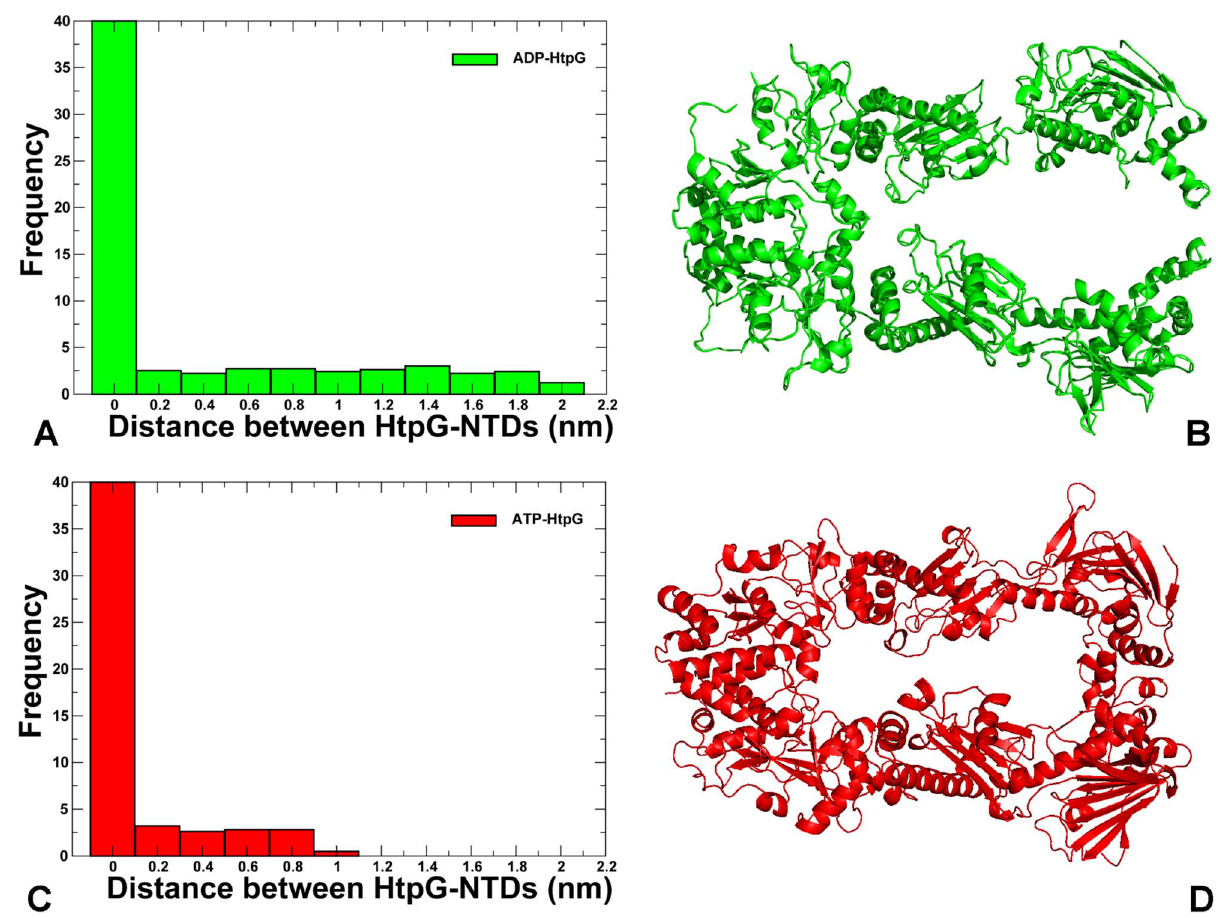
Figure 3. Nucleotide-Dependent Conformational Changes in the HtpG Chaperone. Conformational changes in the ADP-bound HtpG (A,B) and ATP-bound HtpG complexes (C,D) show that HtpG can experience opening and closing motions that are nucleotide-specific. The normalized frequency of the average distance between the HtpG-NTDs is shown for ADP-HtpG as a green-colored histogram (A) and for ATP-HtpG as red-colored histogram (C). The first bar in both histograms is deliberately truncated to make the small fraction of the distribution corresponding to the NTDs separation visible. The average structure of ADP-HtpG is shown in green ribbons (B) and the average conformation of ATP-HtpG is shown in red ribbons (D). The ADP-bound HtpG structure revealed a partial coordinated separation of the NTDs and MDs. The ATP-bound HtpG complex remained in the closed conformation during simulations.